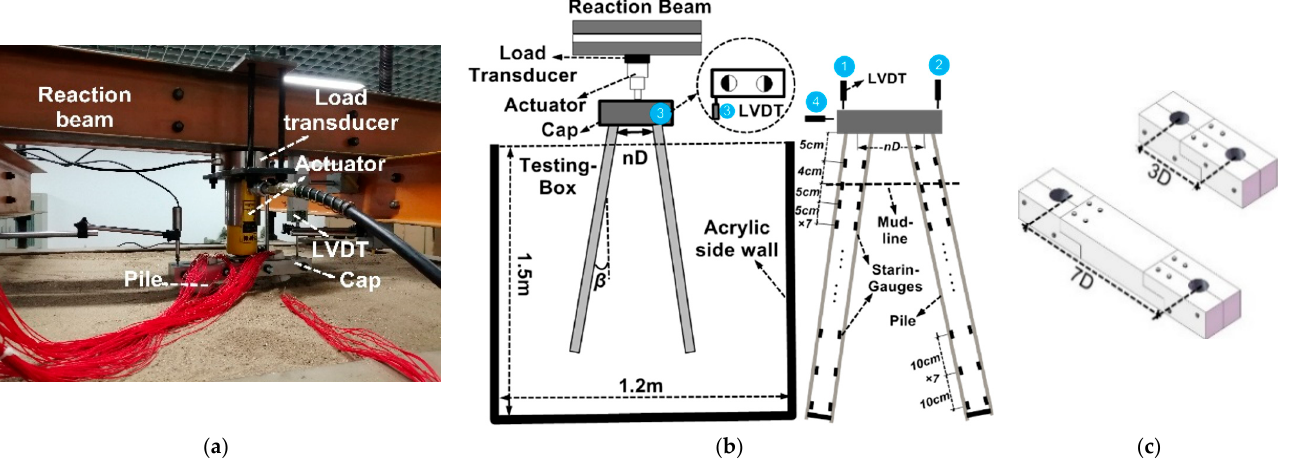
Figure 3. Equipment and sensors of the test: ( a ) testing photo, ( b ) the arrangement of sensors, and ( c ) the cap with a variable pile spacing.